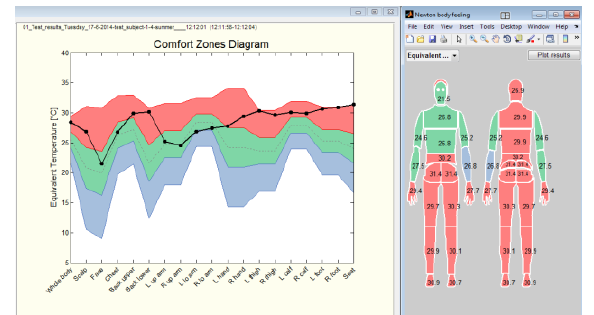
Fig. 3. Comfort zone diagram for summer; corresponding to the conditions of test subject N.2 after 30 min.